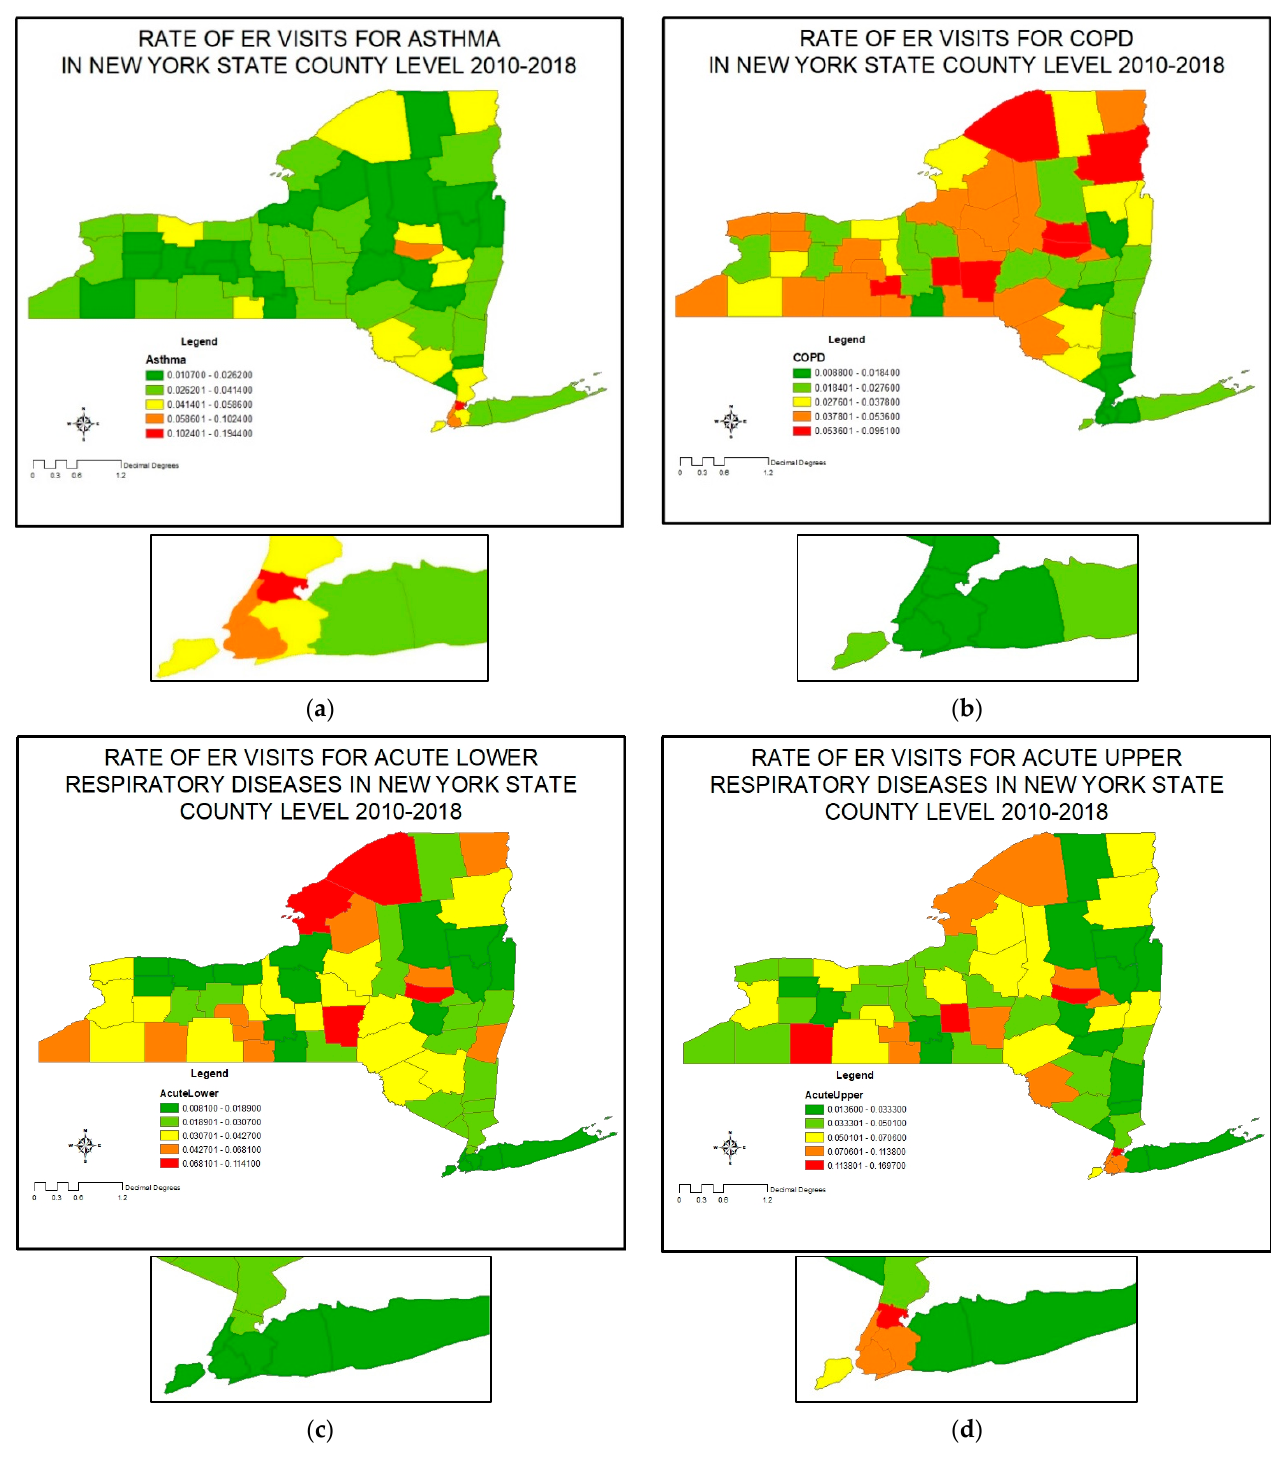
Figure 1. Rate of ER visits for respiratory diseases 2010–2018 by county: ( a ) asthma; ( b ) COPD; ( c ) acute lower respiratory diseases; ( d ) acute upper respiratory diseases. The insert shows the New York City region at higher magnification.